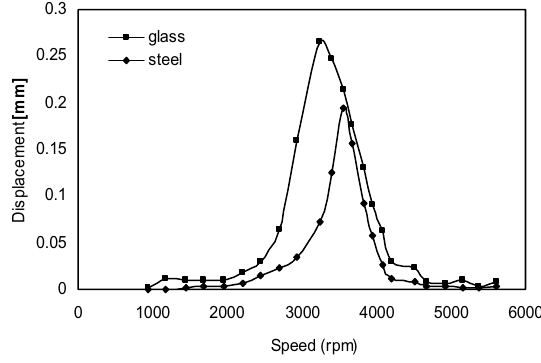
Fig. 7. Damper material effect on vibration amplitude (L/D = 0.3).